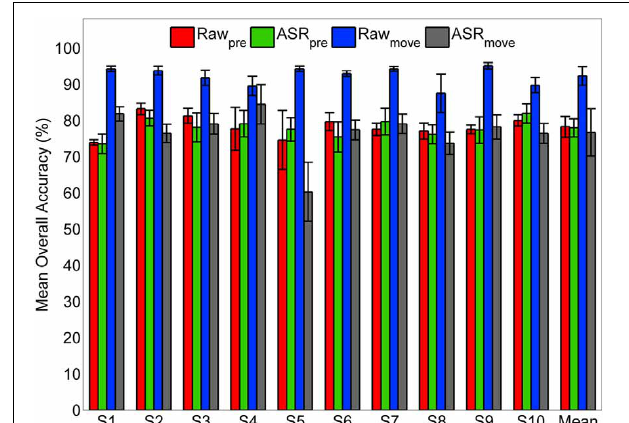
FIGURE 11 | Classification accuracy using pre- and post-movement epochs with and without ASR pre-processing. The classifier was trained and tested for the self-initiated case using pre-movement epochs with the original pre-processing pipeline (ASR pre , green) and using pre-movement epochs omitting ASR from pre-processing (Raw pre , red). As a control, the classifier was also trained and tested using equally sized epochs (1.5s) immediately following movement onset that were pre-processed with (ASR move , gray) and without (Raw move ) ASR for artifact rejection.